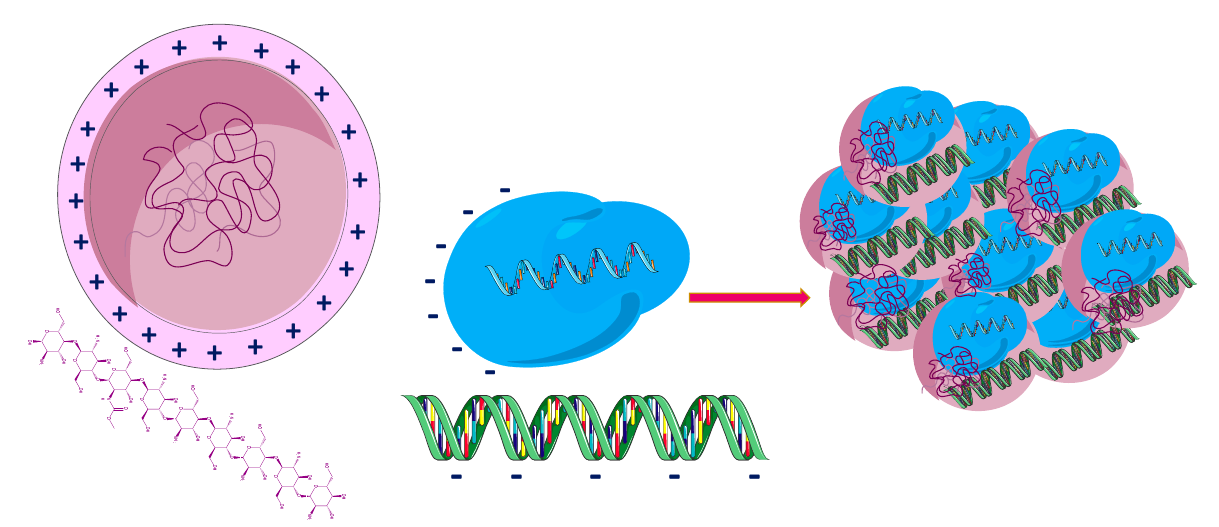
Figure 5. Nanoassembly of fluorescent protein − CTS Cas9/sgRNA and gene − donor. Adapted from [101], MDPI, 2020.